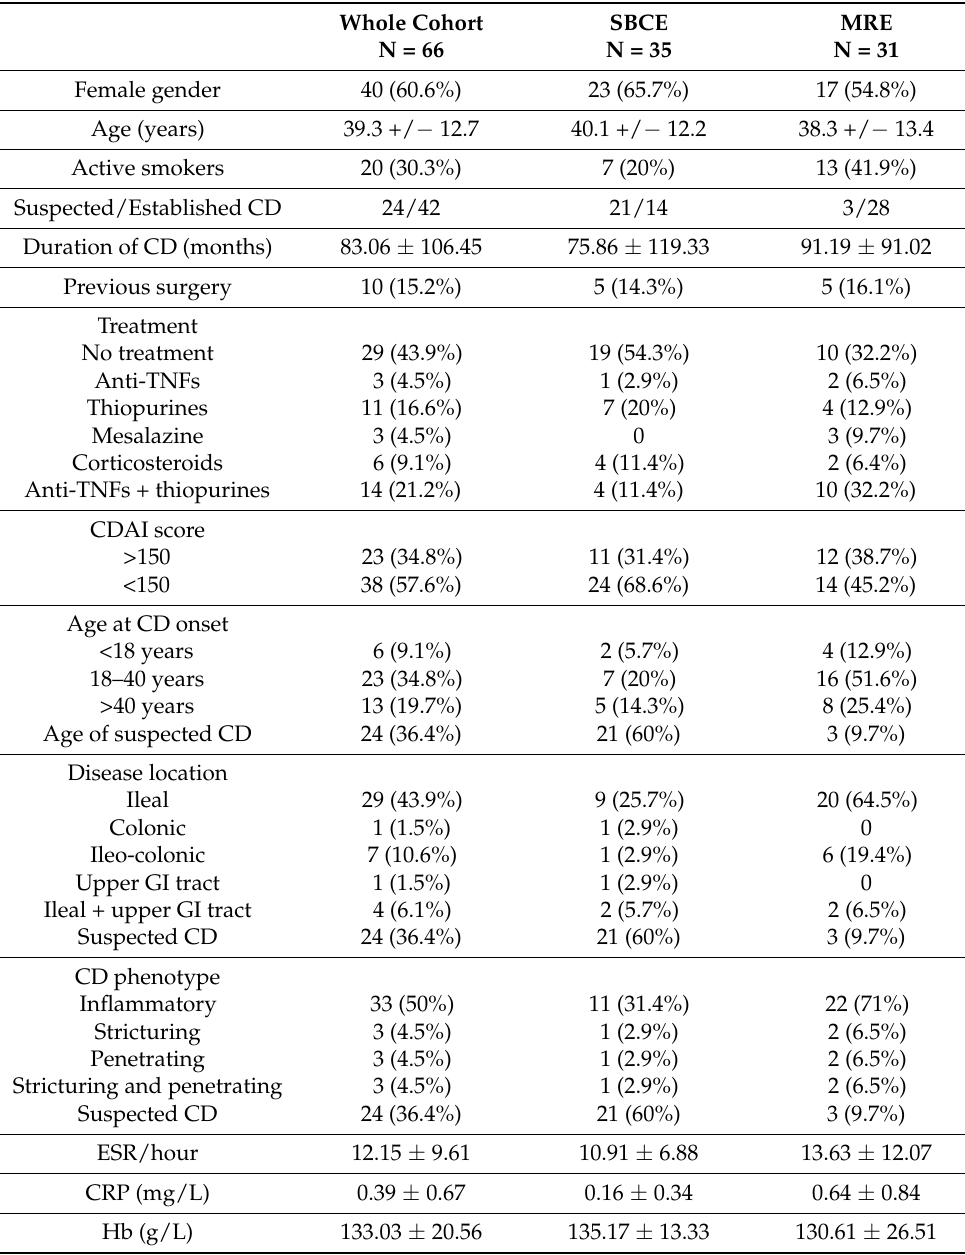
Table 1. Demographic, clinical, and analytical